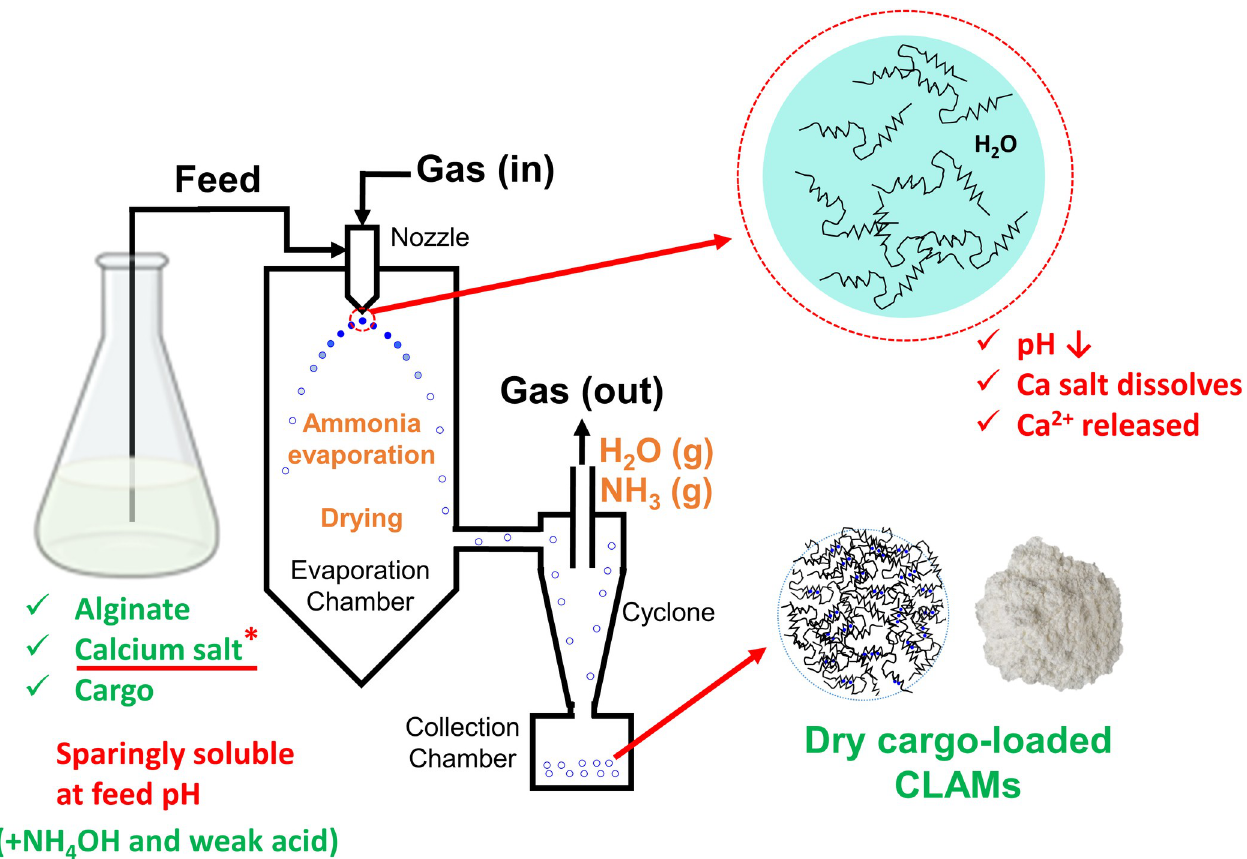
Fig 1. Schematic of the spray-dried CLAMs process. Alginate formulation containing insoluble calcium and a weak acid titrated with a volatile base is atomized in a spray dryer to produce crosslinked alginate microcapsules (CLAMs) in one step. The solution pH drops upon volatilization of the base after atomization, solubilizing calcium to interact with and crosslink negatively charged